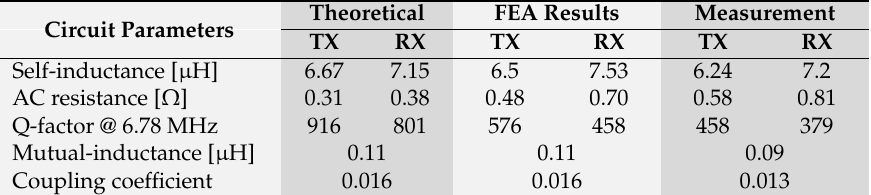
Figure 7. Photos of transmitter and receiver coils: ( a ) Top of transmitter coil; ( b ) Bottom of transmitter coil; ( c ) Top of receiver coil; ( d ) Bottom of receiver coil. Table 4. Circuit parameters of the designed coils at 6.78 MHz.